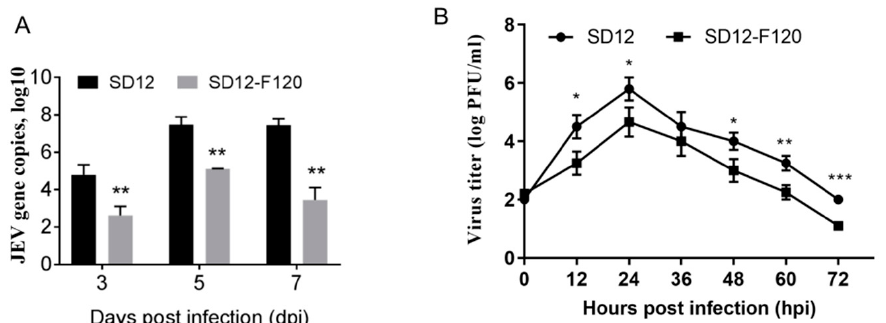
Figure 2. Replication of SD12-F120 and SD12 in mouse brains and mouse primary neuron cells. ( A ) Mice (10 mice / group) were intracerebrally inoculated with SD12-F120 or SD12. Brain samples were collected at 3, 5, and 7 dpi. The viral loads in the brain samples were measured by qRT-PCR. ( B ) Primary mouse neuron cells were infected with SD12-F120 or SD12 at an MOI of 0.01. The viral titers in the supernatants were measured by plaque assays. Data are presented as mean ± SD from three independent experiments. * p < 0.05; ** p < 0.01; *** p < 0.001 tested by Student’s t -test.